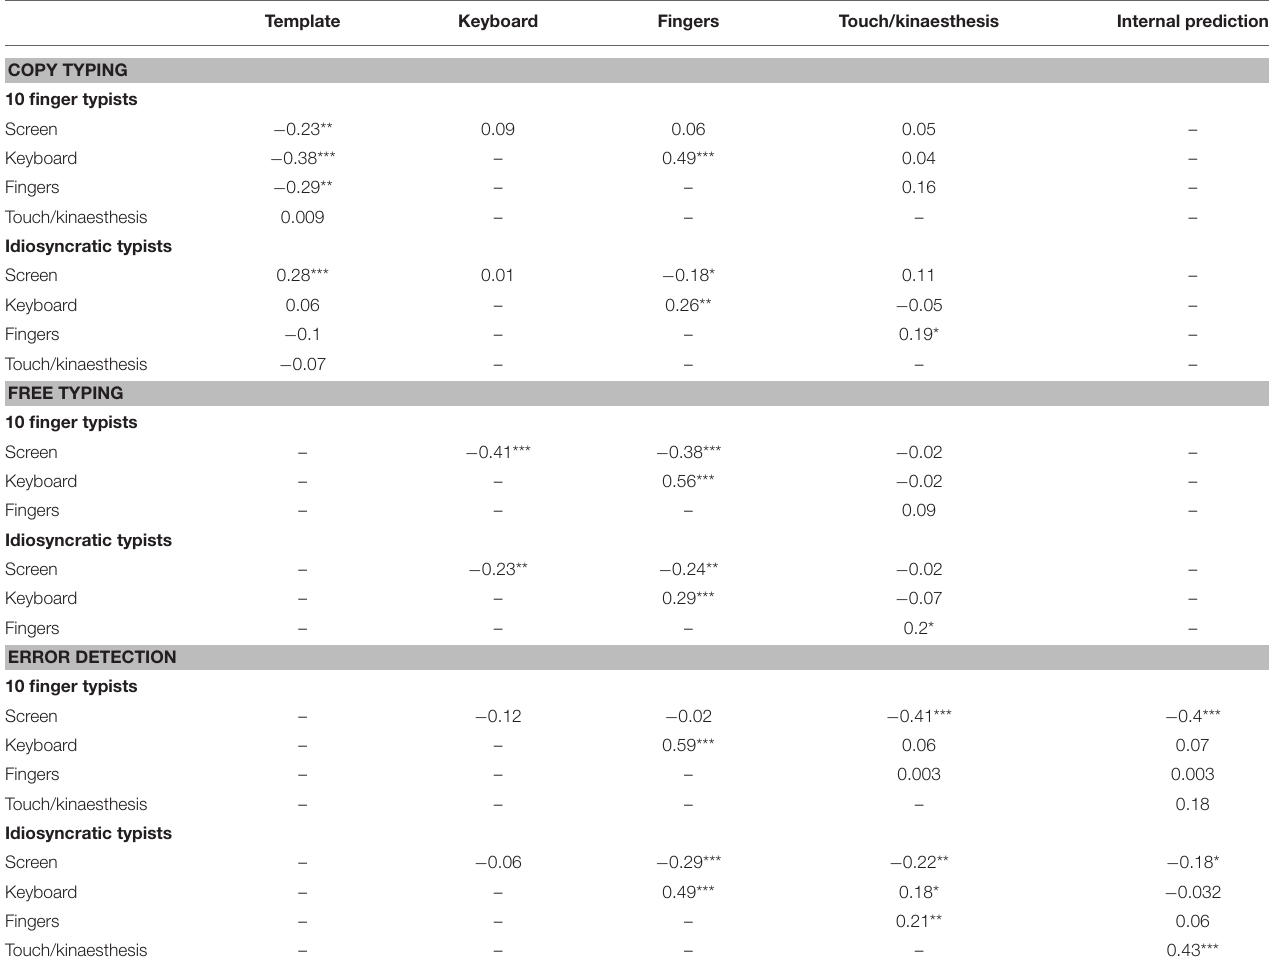
TABLE 3 | Correlations between the extent of attention to/use of different sources of information in copy typing, free typing, and error detection separately for 10 finger typists and idiosyncratic typists.